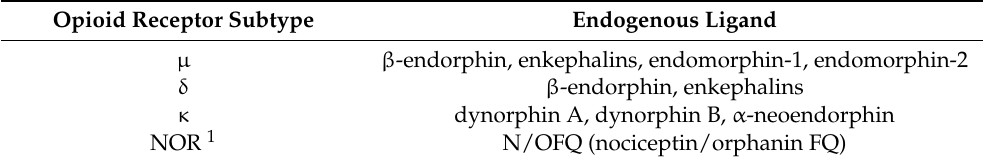
Table 1. Four subtypes of opioid receptor and a list of their endogenous ligands. Opioid Receptor